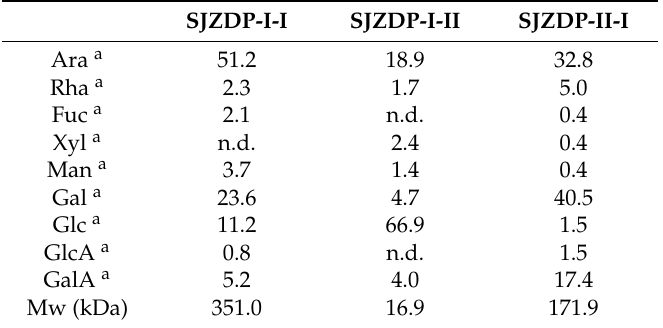
Table 1. Monosaccharide compositions (mol %) and Mw of polysaccharide fractions SJZDP-I-I,